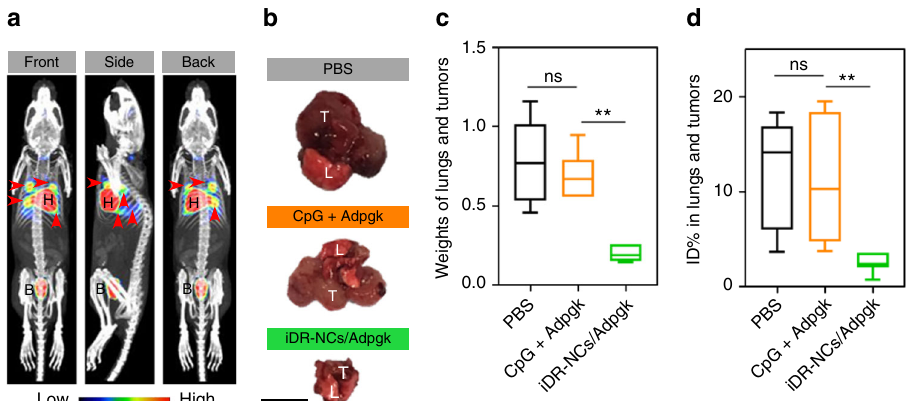
Fig. 8 iDR-NC/neoantigen as potent nanovaccines for neoantigen-speci fi c tumor immunotherapy. 1 × 10 5 MC38 cells were i . v . injected into C57BL/6 mice, and mice were treated by s.c. injection of CpG/shRNA Stat3 /neoantigen iDR-NCs (2 nmol CpG equivalents, 17 μ g Adpgk) at the tail base on days 10, 16, and 22. a Representative PET-CT images showing the MC38 tumor deposited in lungs on day 40. Mice were randomly picked from the group of PBS-treated mice for PET-CT. Tumor, as well as heart and bladder were illuminated by FDG. Arrow heads mark tumor nodules. H heart, B bladder. b Representative photographs (scale bar: 1 cm.), c weights, and d %ID of FDG of lungs and tumors from as-treated mice on day 40 post tumor inoculation. T tumor, L lung. (** p < 0.01; *** p < 0.001; ns: not signi fi cant; n = 6; one-way ANOVA with Bonferroni post-hoc test). Data represent mean ±